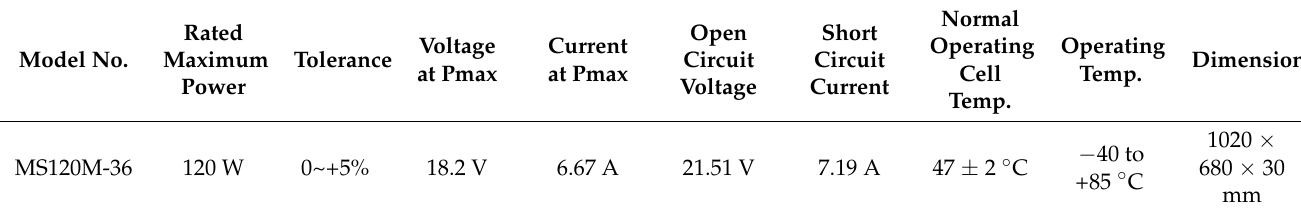
Table 1. Specifications of the PV panels used in the experimental tests [32].